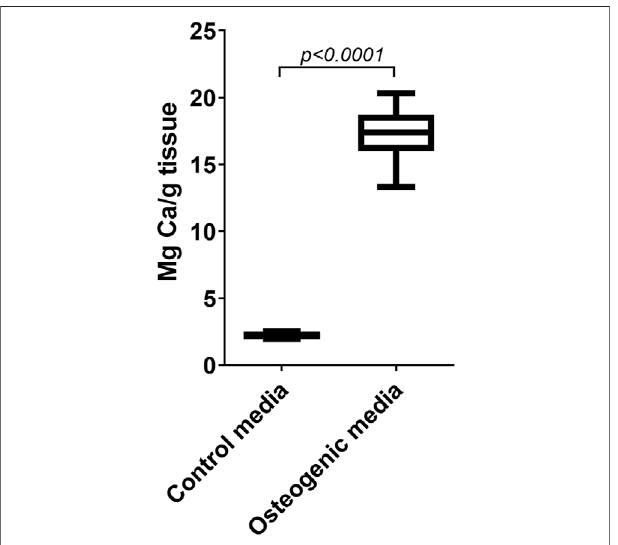
FIGURE 10 | Induced calci fi cation in porcine whole lea fl ets cultivated ex vivo . Calcium accumulation in whole pig lea fl ets cultivated for 4 weeks in control growth media and in osteogenic media. The amount of calcium was measuredbyinductivelycoupledplasmaopticalemissionspectroscopy. The data are shown as box plots and wiskers with 5 – 95%